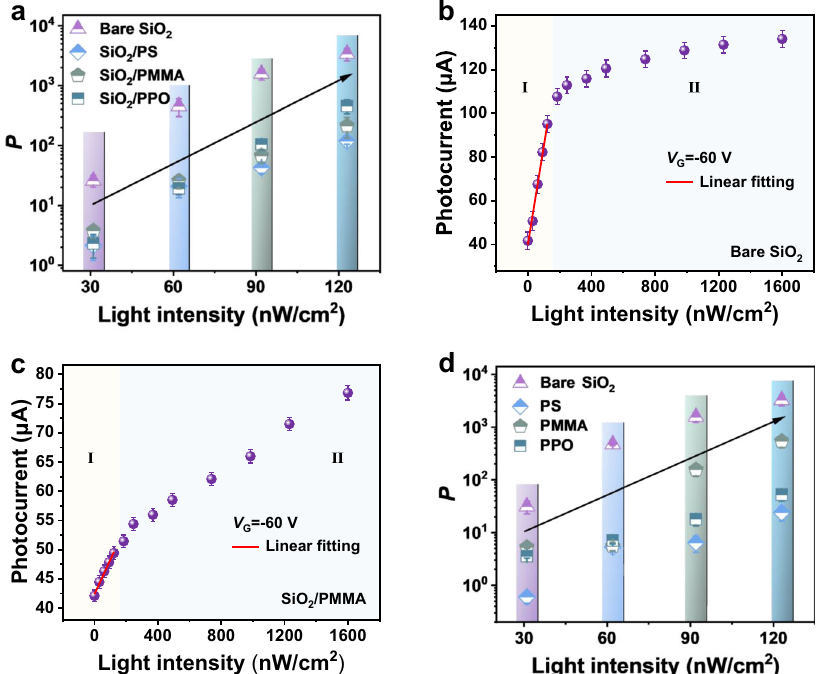
Fig. 2 | The photosensitivity and photocurrent of OPTs under various illumi- nationintensities.a P indifferent interface(bare and buffer layers modi fi ed SiO 2 ) as a function of low illumination intensity. b The dependence of photocurrent on light intensity based on bare SiO 2. c The dependence of photocurrent on light